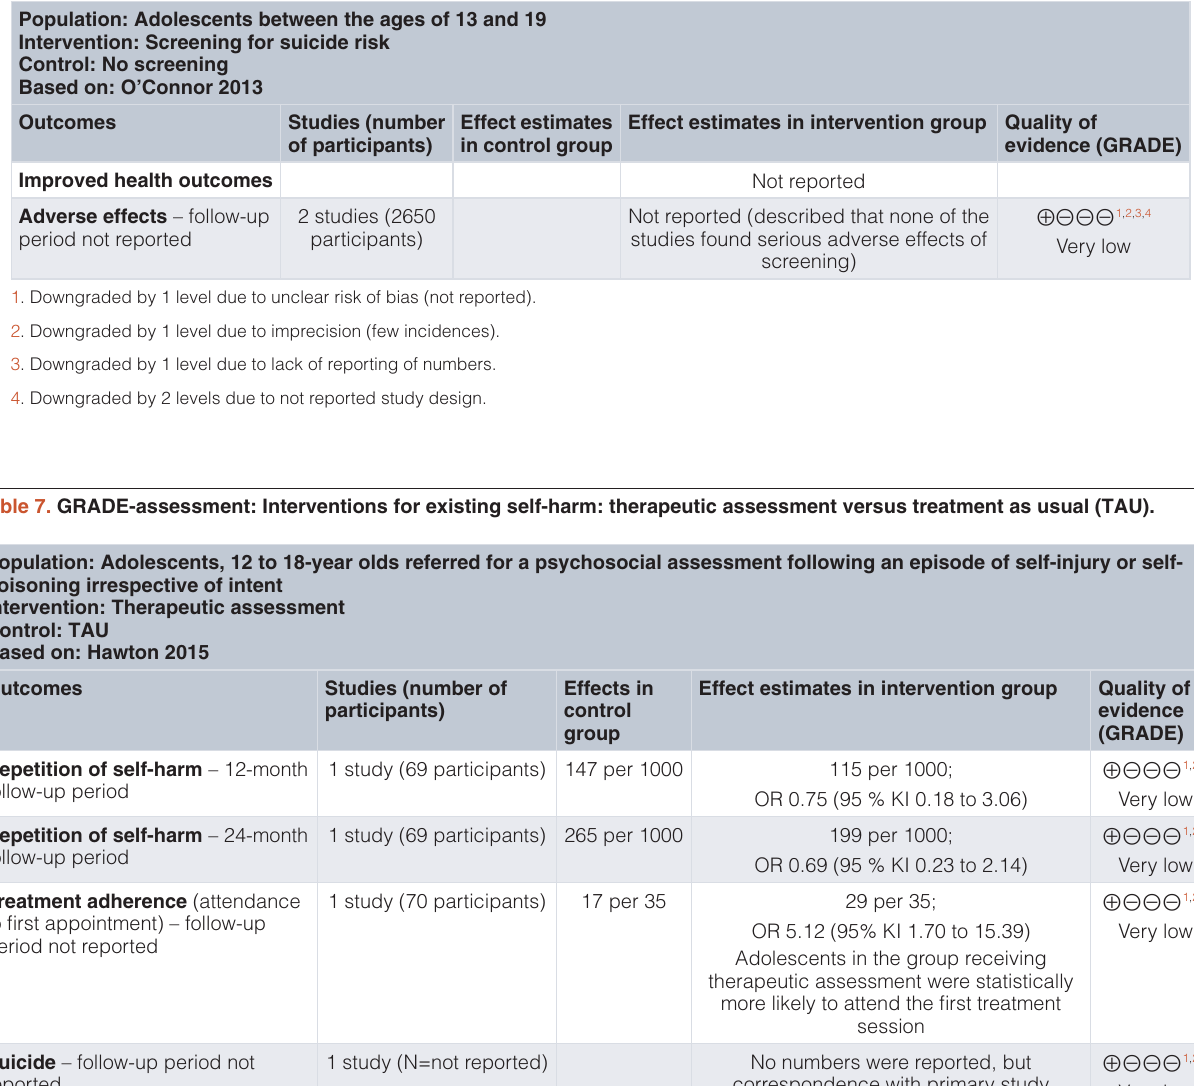
Table 6. GRADE-assessment: Primary prevention: screening for suicide risk versus no screening. Population: Adolescents between the ages of 13 and 19 Intervention: Screening for suicide risk Control: No screening Based on: O’Connor 2013